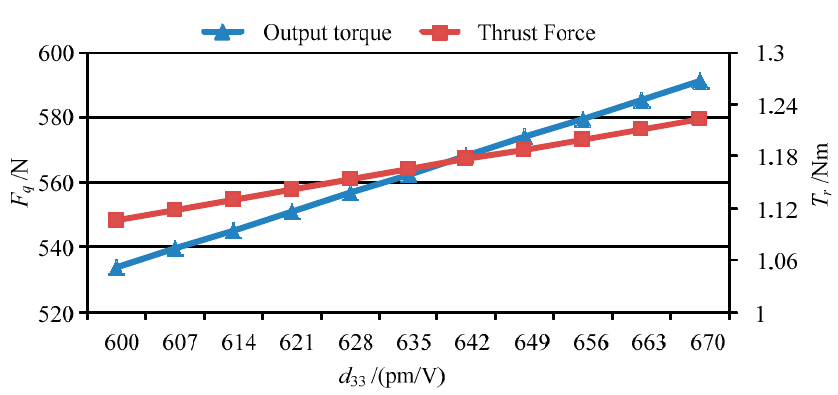
Figure 14. The output torque and thrust force vary with d 33 .